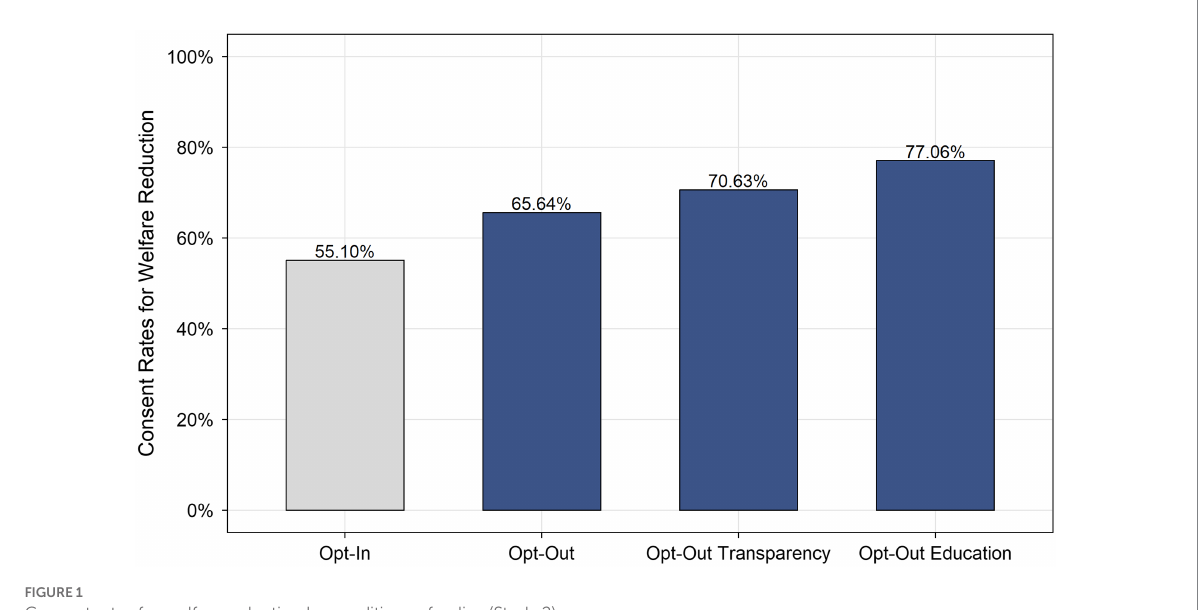
FIGURE 1 Consent rates for welfare reduction by conditions of policy (Study